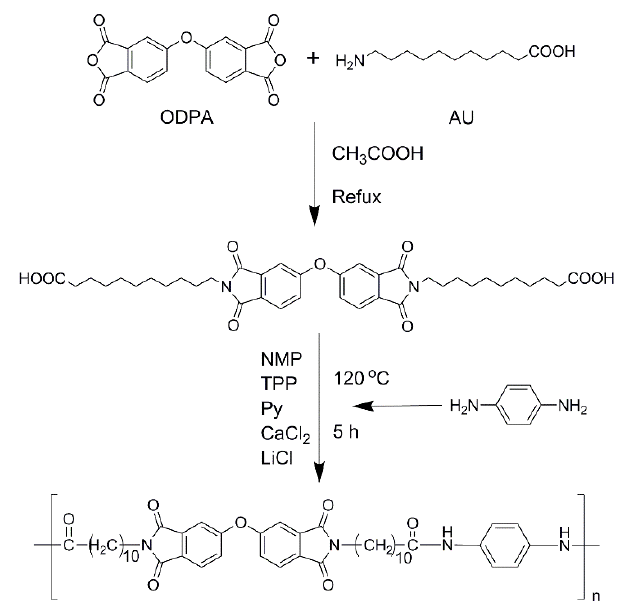
Figure 1. Synthetic route of diimide diacid monomer and aromatic poly(amide-imide) (PAI).